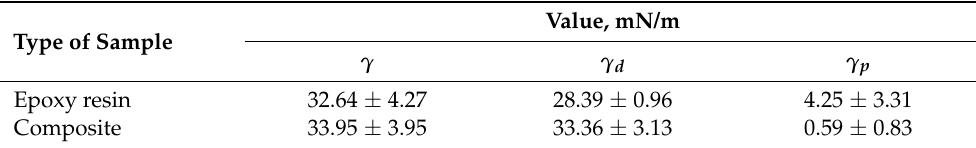
Table 7. Free surface energy of materials. Type of